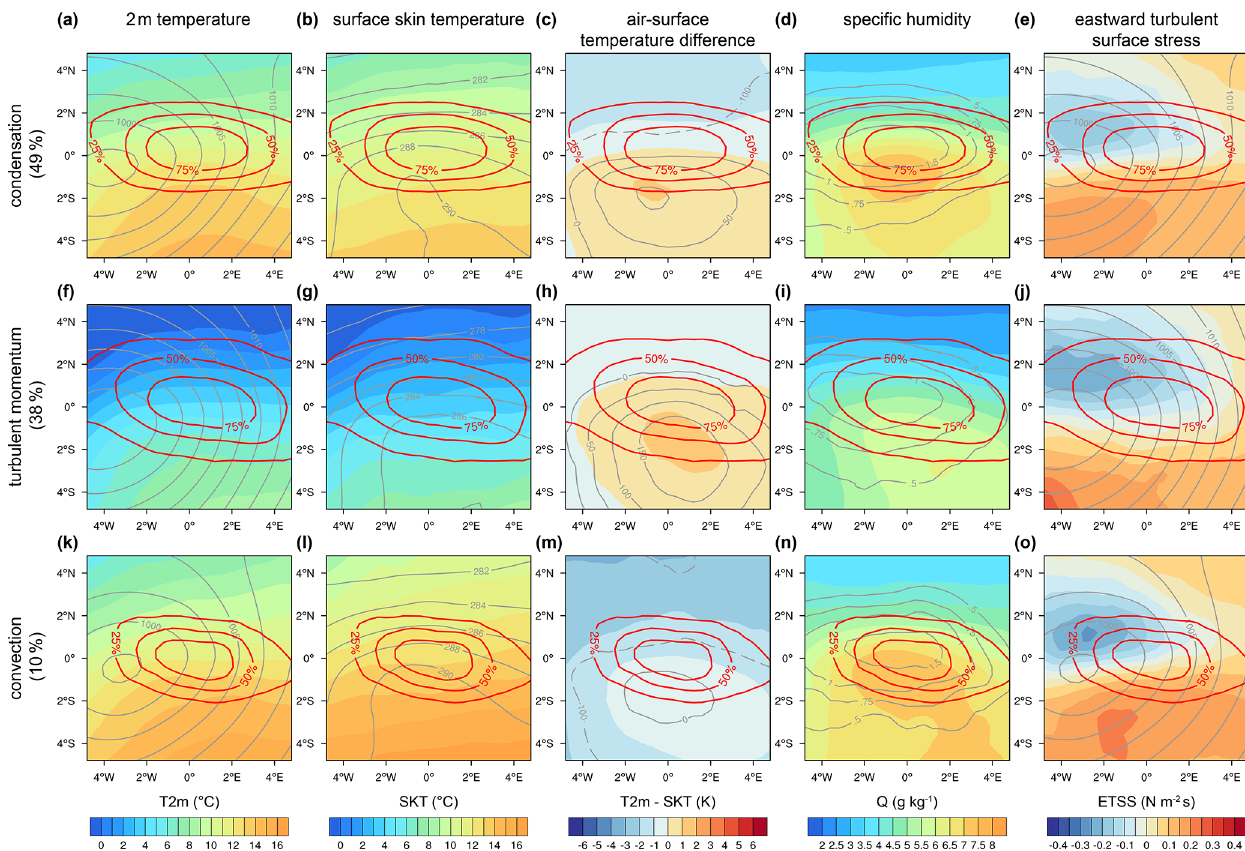
Figure 8. Similar to Fig. 7 but for the positive PV anomaly along the warm front in the cold season. Gray contours show sea level pres- sure (a, f, k, e, j, o) , θ at 900hPa (b, g, l) , surface sensible heat flux (c, h, m) , and total precipitation (d, i, n)